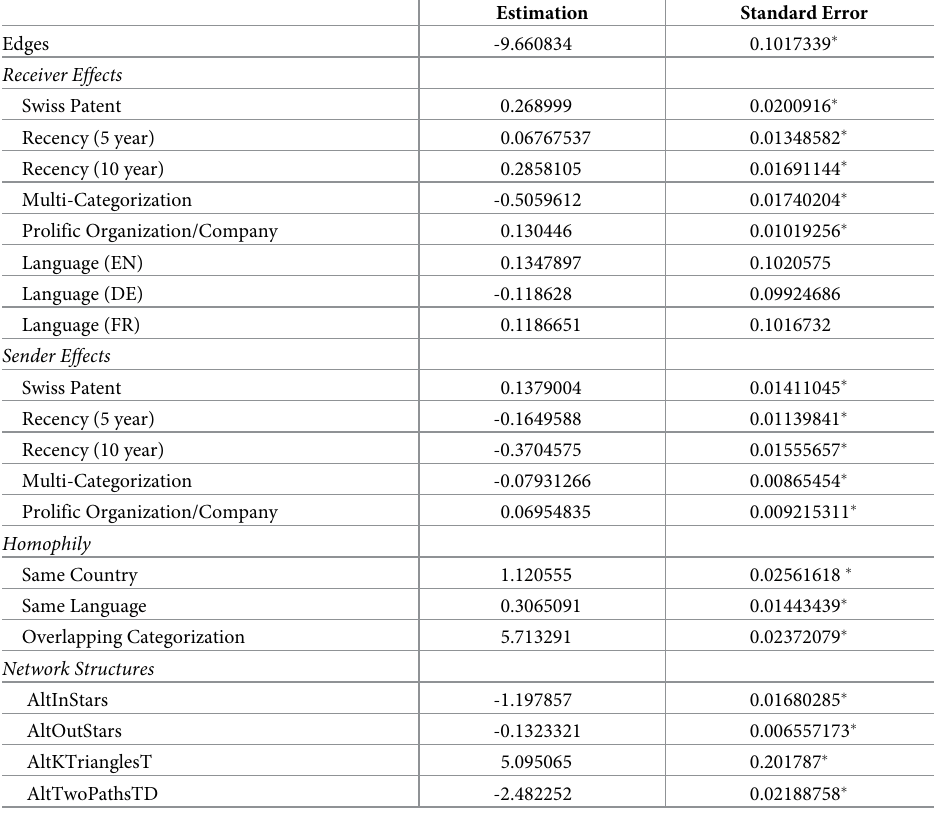
Table 7. ERGM results for predicting the sector E citation